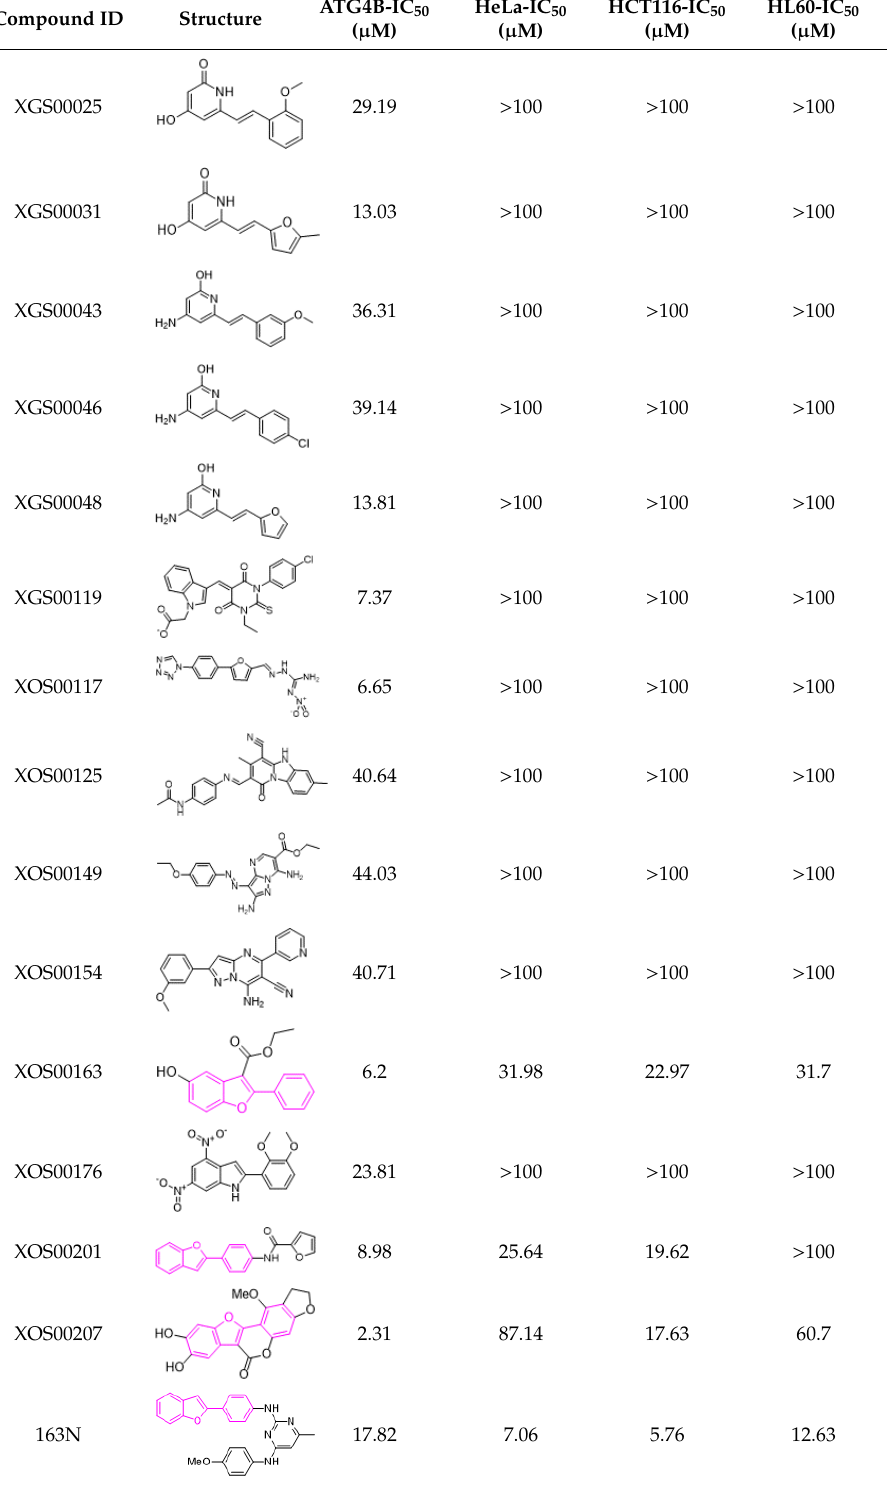
Table 1. List of the screened ATG4B inhibitors.